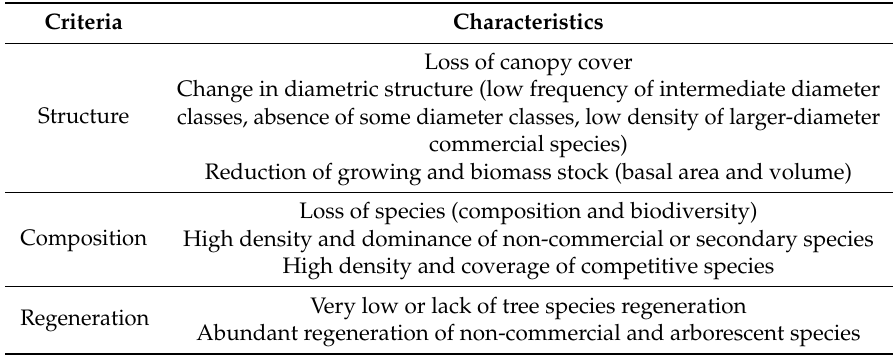
Table 1. Preliminary guidelines for recognition of a degraded forest: criteria and characteristics for categorization as